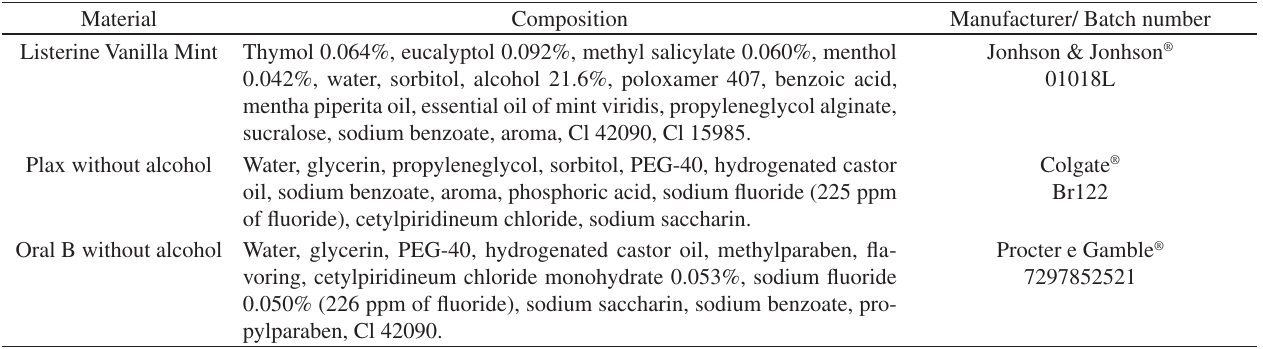
Table 2. Mouthrinses and their composition according to the manufacturers’ information. Material Listerine Vanilla